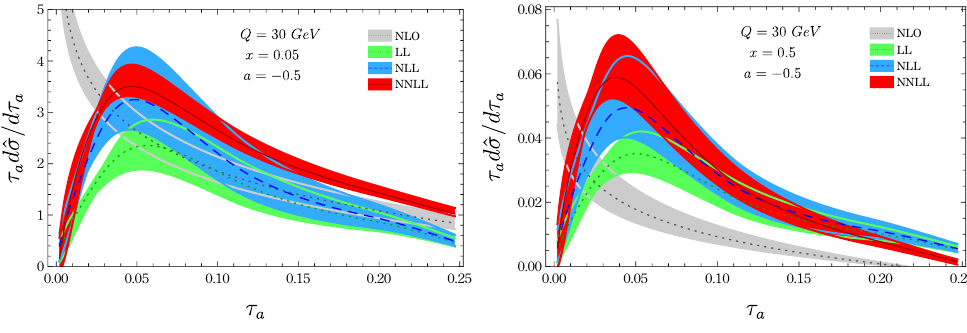
Figure 5 . Angularity cross-section for different x = 0 . 05 , and 0 . 5 at a fixed a = − 0 . 5 and Q = 30 GeV. The band indicates perturbative uncertainty.